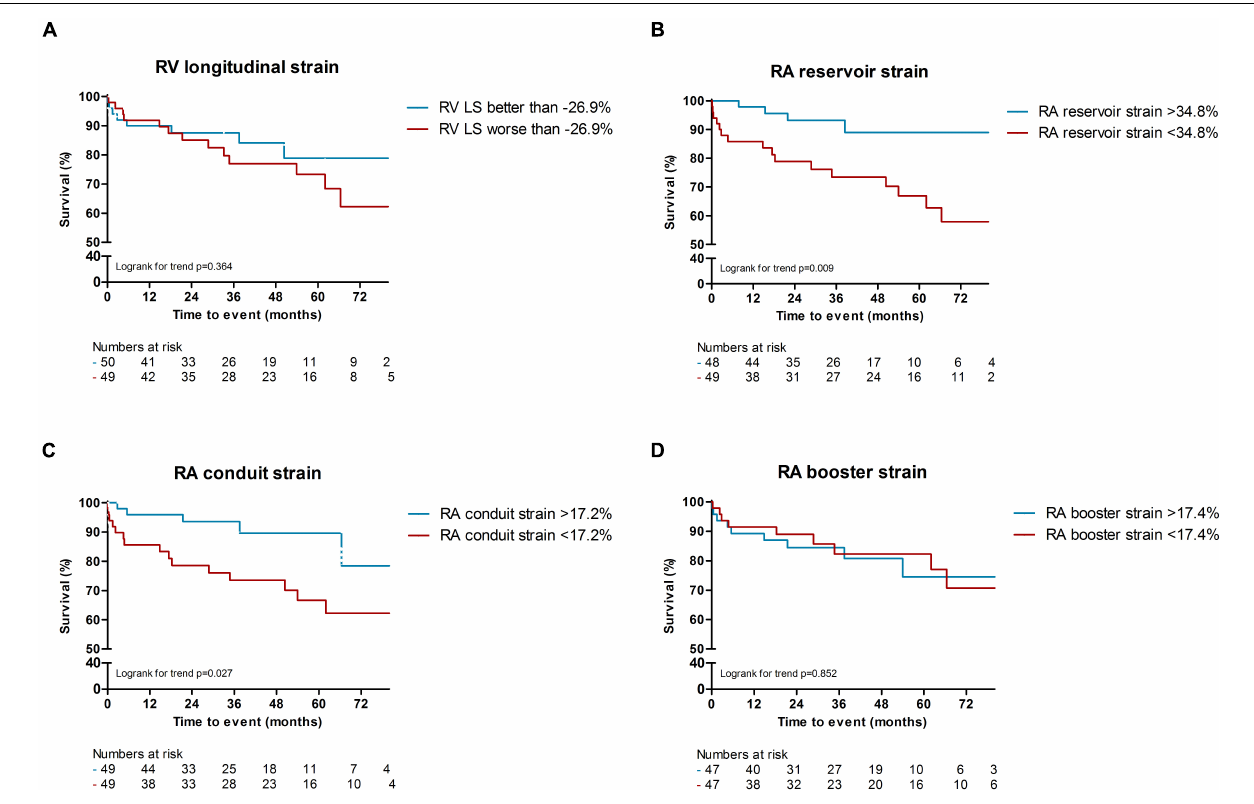
FIGURE 3 | Kaplan Meier survival analysis of RV LS, RA reservoir and conduit strain. RV longitudinal strain above or below the median was not associated with a difference in all-cause mortality [ p = 0.364, (A) ]. RA reservoir ( < 34.8%), and RA conduit strain below the median ( < 17.2%) were associated with higher all-cause mortality rates compared to patients with RA reservoir or conduit strain above the median [ p = 0.009, and p = 0.027, (B,C) ]. Differences in median RA booster strain was not associated with differences in all-cause mortality [ p = 0.852, (D) ]. RV, right ventricular; LS, longitudinal strain; RA, right